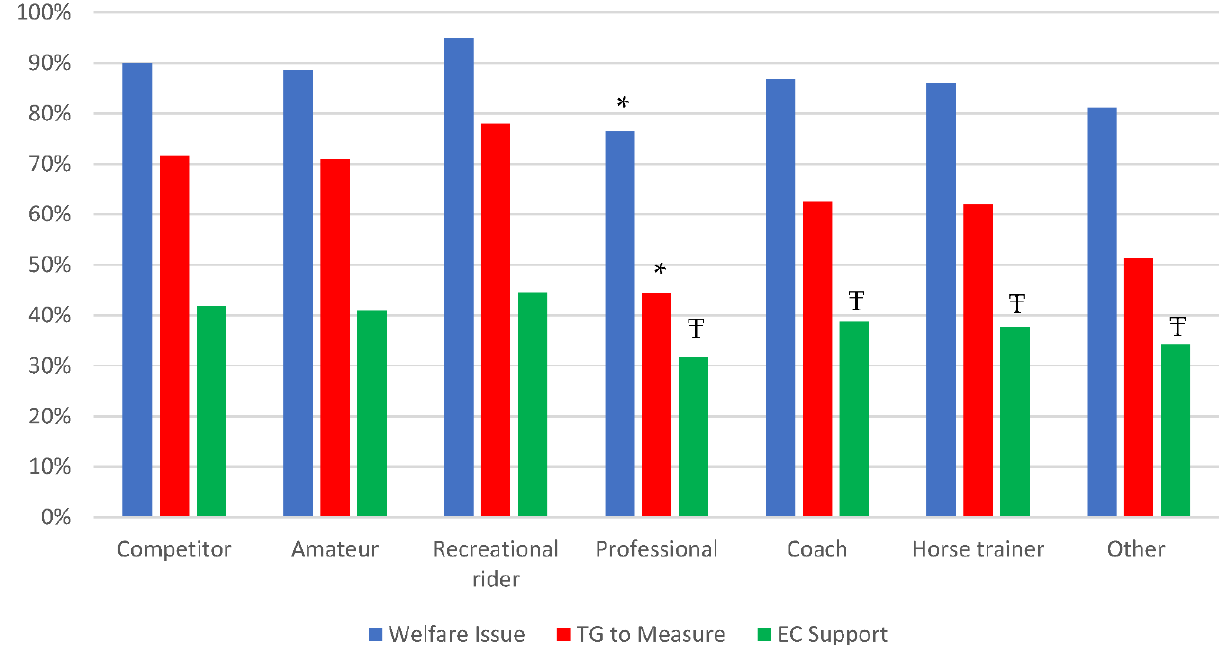
Figure 5. Percentage of member survey respondents ( n = 1528) who agreed that overtightened nosebands were a welfare issue, that a taper gauge was a fair way to measure noseband fit and who supported Equestrian Canada in advancing horse welfare rules in sport according to the role they represent in the equestrian community (note that respondents could select multiple roles). Differs within role * p < 0.0001, Ŧ p = 0.009.